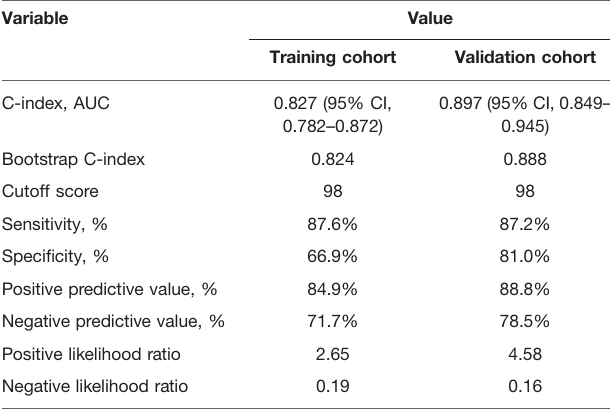
TABLE 5 | Accuracy of the prediction score of the nomogram for estimating the risk of occult locally advanced ESCC. Variable